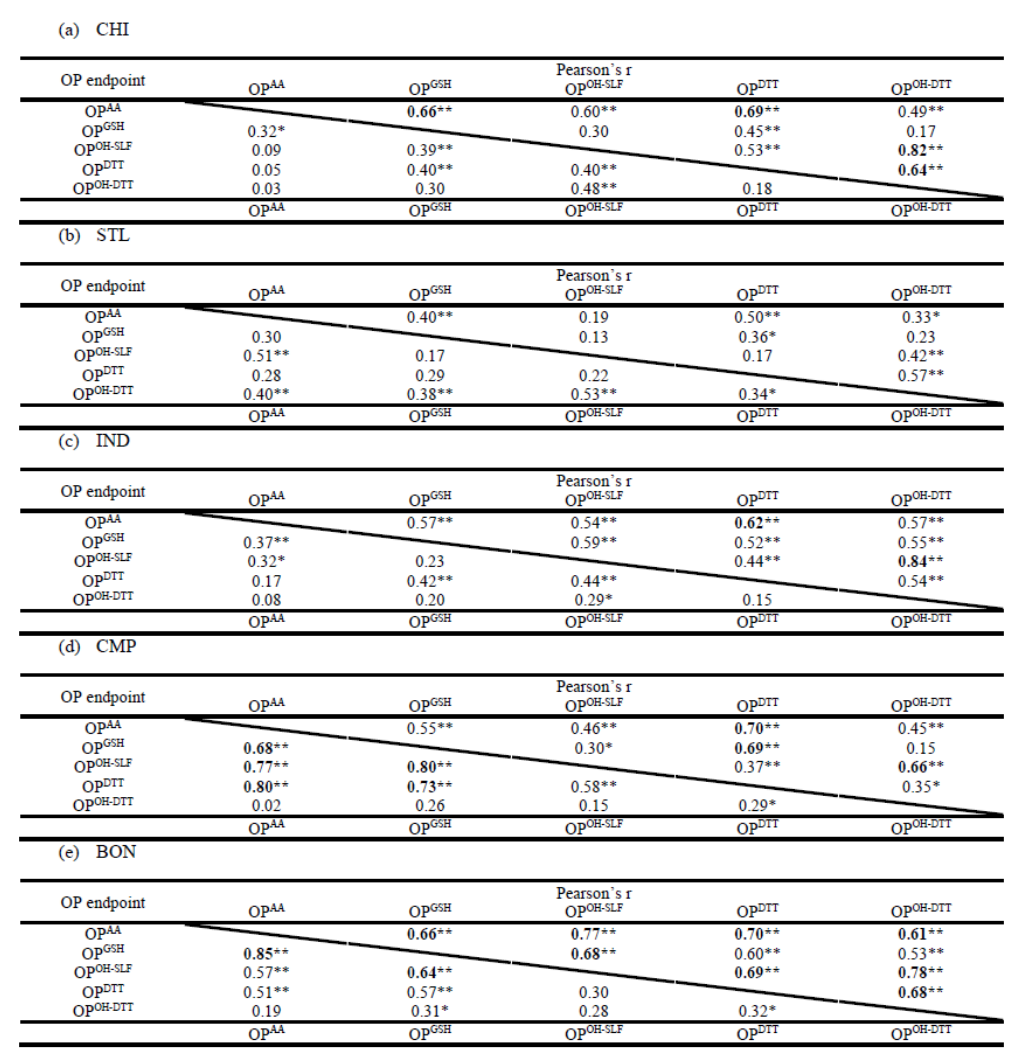
Table 5. Pearson’s correlation coefficient ( r ) among various endpoints of OPv measured at five sampling sites. The values below the diagonal are for water-soluble OPv, while those above are for methanol-soluble OPv. Correlations with r > 0 . 60 are shown in bold. Single asterisks